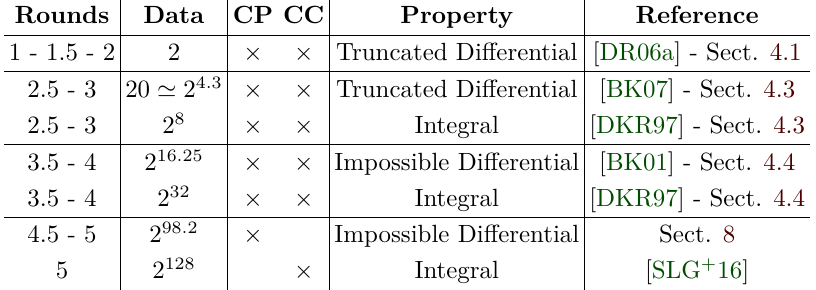
Table 1: AES secret-key distinguishers, working independent of key schedule . Data complexity is measured in minimum number of chosen plaintexts CP or/and chosen ciphertexts CC which are needed to distinguish the AES permutation from a random permutation with probability higher than 95%. The case in which the final MixColumns operation is omitted is denoted by “ r. 5 rounds”, that is r full rounds and the final round. Rounds